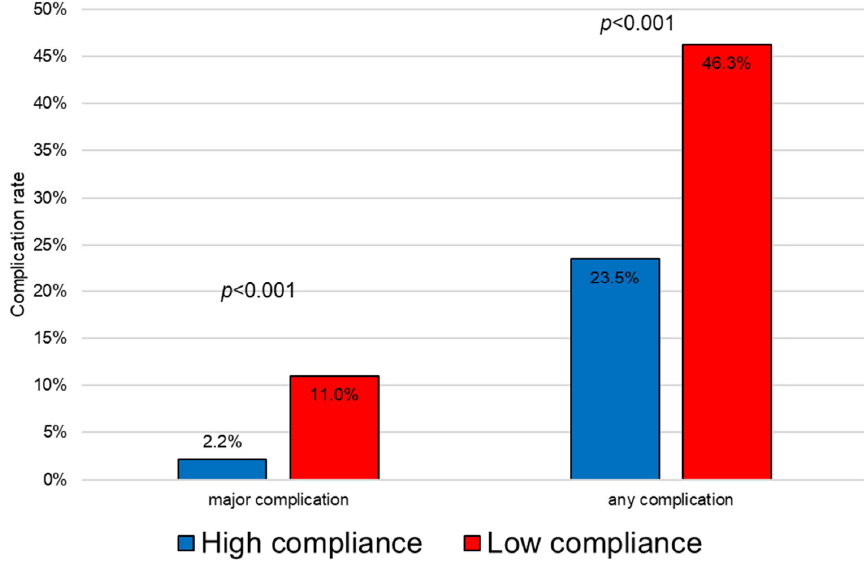
Figure 1. Correlation between morbidity and compliance on postoperative day 2. Table 5. Variables associated with any complication.